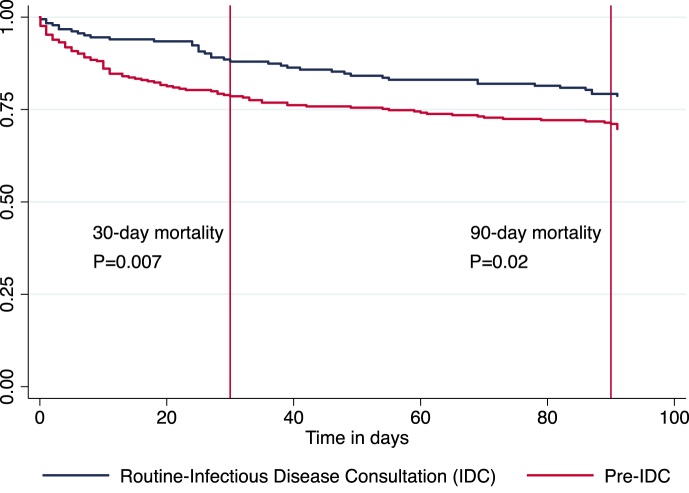
Kaplan-Meier survival estimate for adults with SAB.